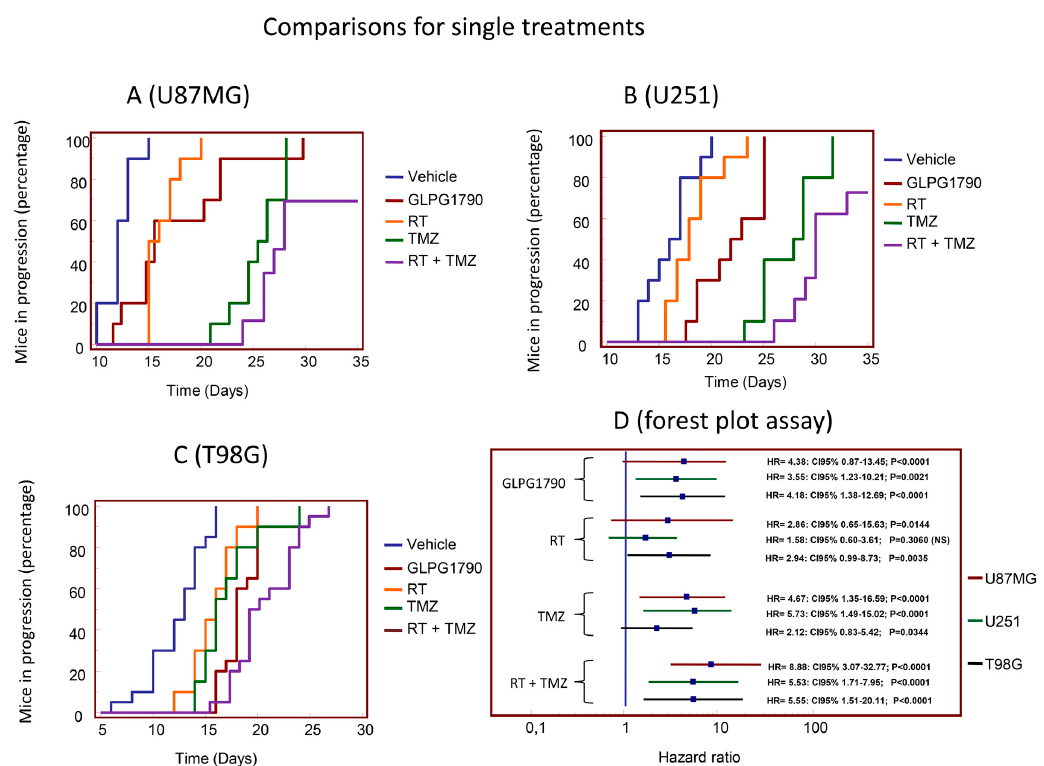
Figure 4. In vivo experiments: GLPG1790-modified tumour growth of GBM cells subcutaneously injected in female nu/nu mice (xenograft model). In vivo efficacy of single dose (30 mg/Kg/day) of GLPG1790 compared with standard RT (1 dose of 4 Gy), chemo (TMZ, 16 mg/kg for 5 consecutive days) and chemo and radio (4 Gy + 16 mg/kg TMZ) therapy. ( A ) Percentage of mice in progression plotted for the time by using Kaplan–Meyer analysis for U87MG cell model. ( B ) Percentage of mice in progression plotted for the time by using Kaplan–Meyer analysis for U251 cell model. ( C ) Percentage of mice in progression plotted for the time by using Kaplan–Meyer analysis for T98G cell model. ( D ) Forrest plot analysis. In Table S1, we summarised the statistical analysis of xenograft experiments.